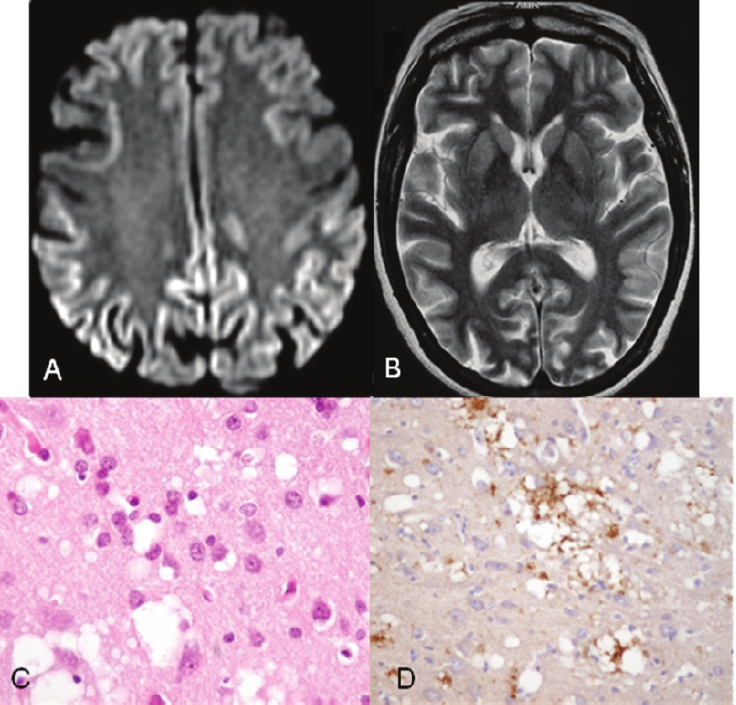
Fig.2. A.Axial T2showssymmetrical highsignal lesions incaudate nuclei and putamina; B.AxialDWIshowswidespread cortical hyperintensity; C. Hematoxilin-eosin preparation shows spongiform changes with astrocytic proliferation; D. Immunocytochemistry with antibody L42 reveals a perivacuolar staining